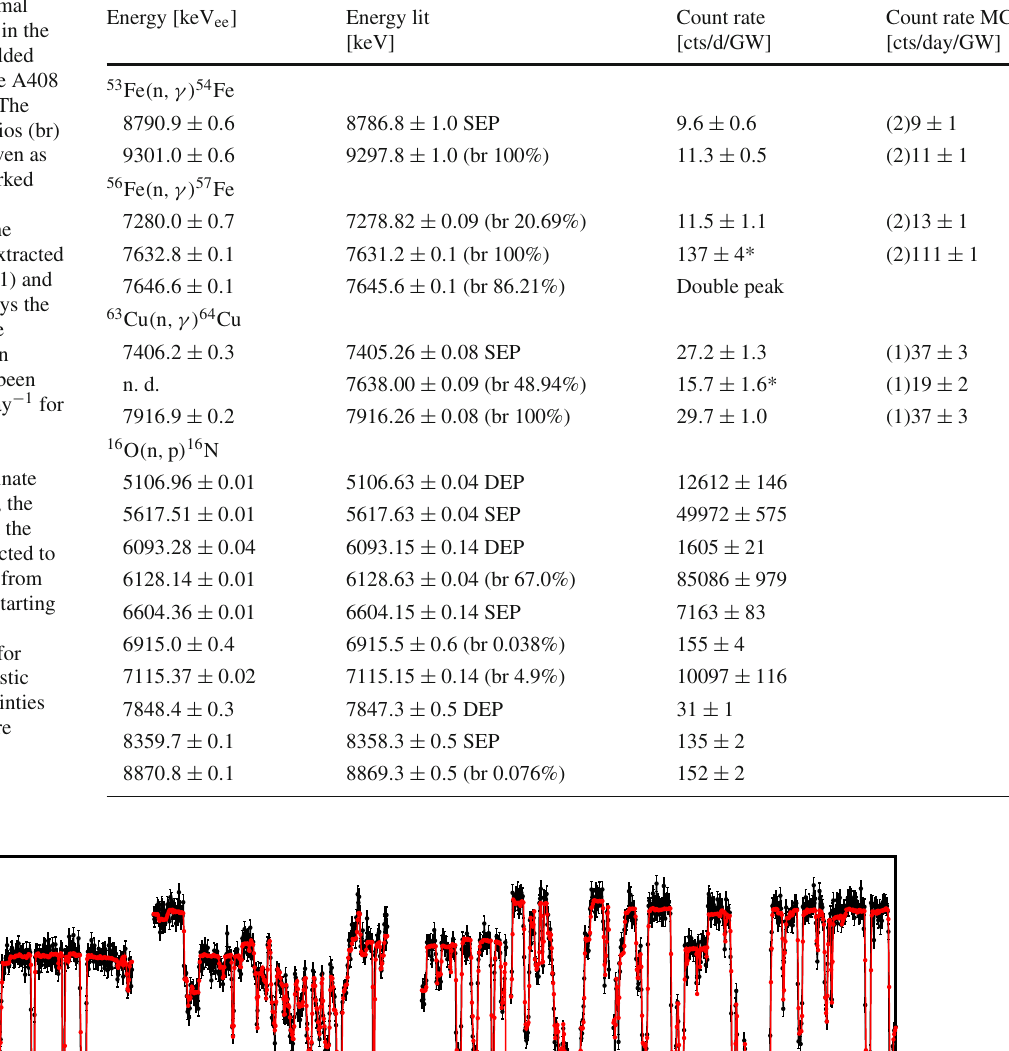
power correlated γ -lines in the